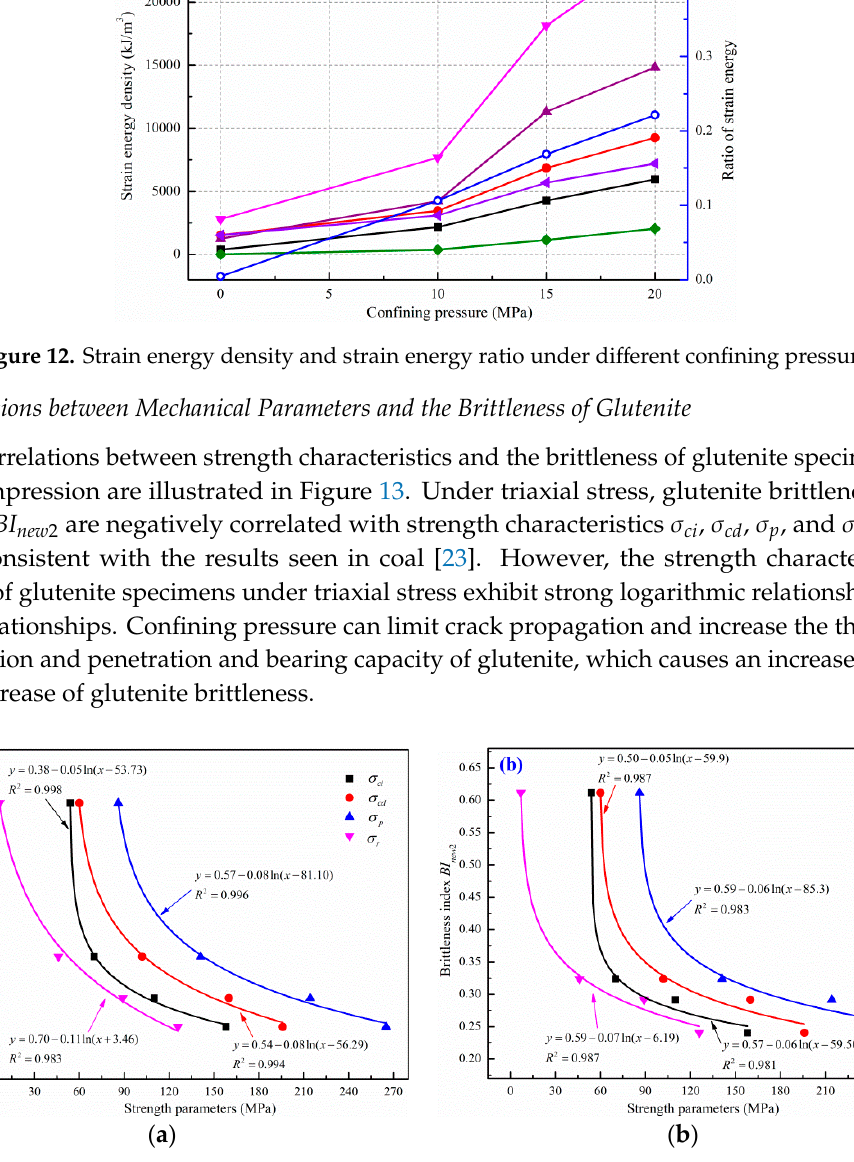
1 and ( b ) BI new 2